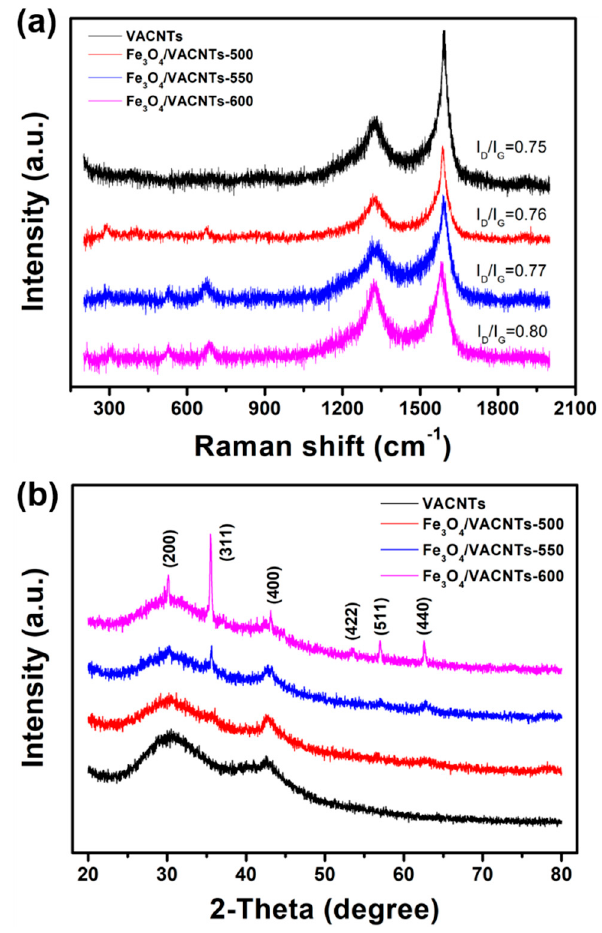
Figure 1. XRD patterns ( a ) and Raman spectra ( b ) of the VACNTs and Fe 3 O 4 /VACNTs composites annealed at different temperatures.